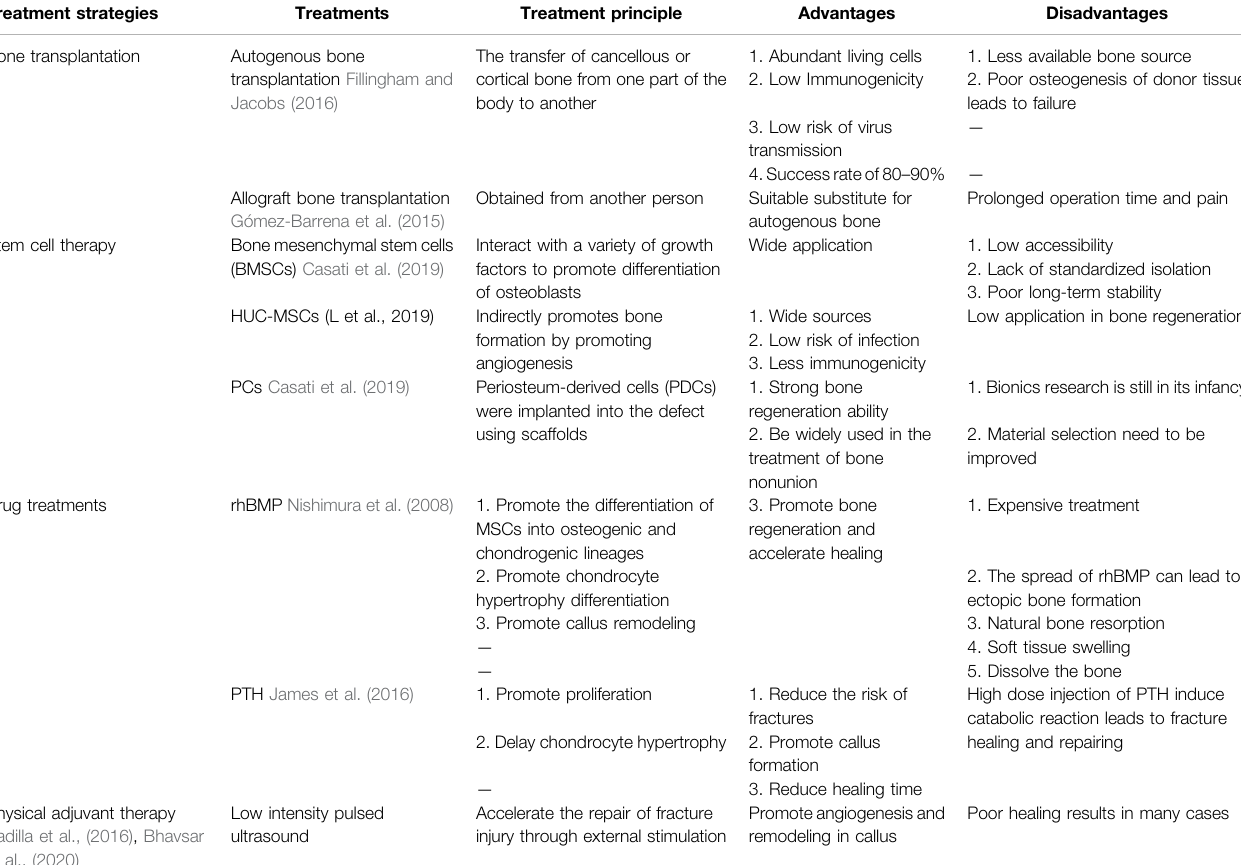
TABLE1 | Therapies to promote bone